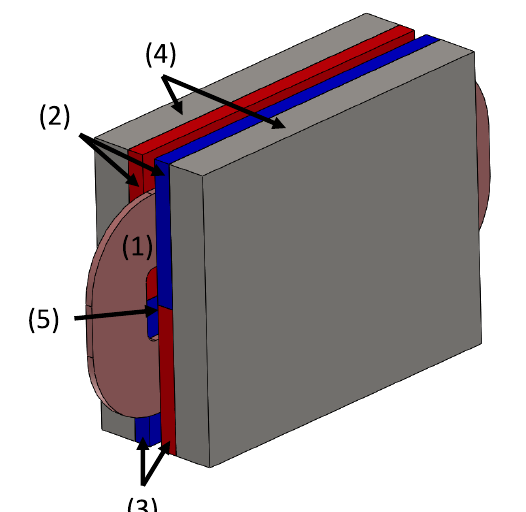
Figure 8. Components of the actuator: (1) Coil; (2) Superior PMs; (3) Inferior PMs; (4) Iron pieces; (5) Air gap. Red and blue colors on the magnets correspond to opposite magnetization